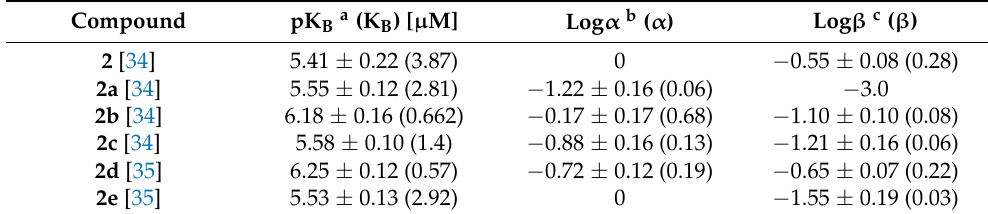
Figure 4. Derivatives of allosteric modulator 2 . Table 2. Examples of derivatives of compound 2 . a Estimate of the negative logarithm of the equilib- rium dissociation constant determined in an cAMP functional assay . b Estimate of the logarithm of the net cooperativity factor between the modulator and dopamine. c Estimate of the logarithm of the modulatory effect upon efficacy factor induced by the allosteric modulator. Values represent the mean ± SEM from at least three independent experiments performed in